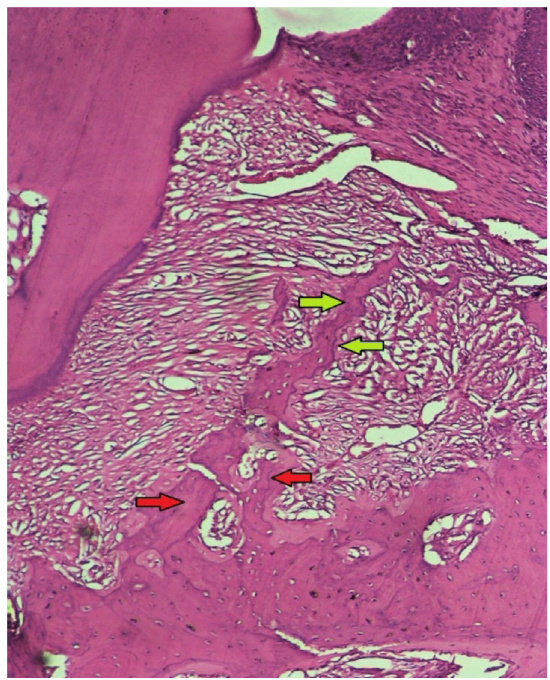
Fig. 9. Photomicrograph of histological section of extraction socket at 10 (cid:3) ; Group B, day 14, showing the pattern of bone formation. Bone formation starts from apical region (red arrows) and advances towards middle third (green